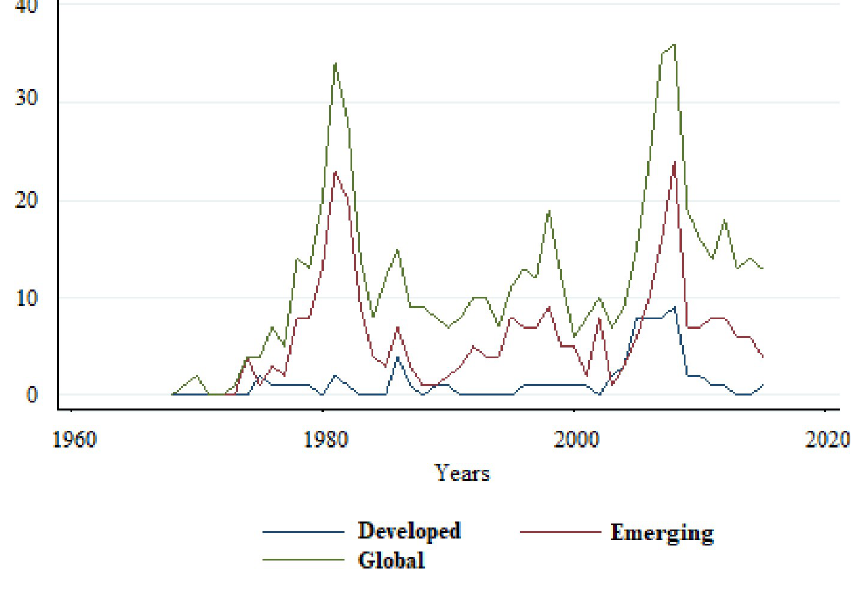
Fig 1. Number of sudden